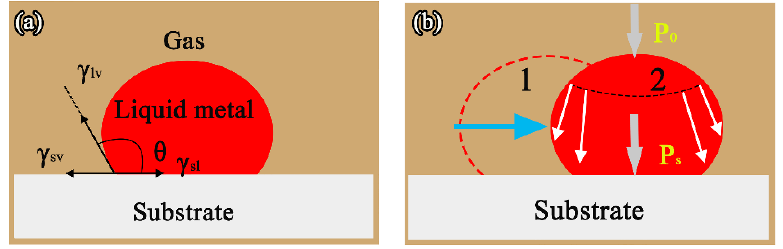
Figure 11. Schematic configurations of a sessile drop in the case of θ > 90°: ( a ) at the solid-liquid-vapor triple line; and ( b ) from 1st to 2nd position.